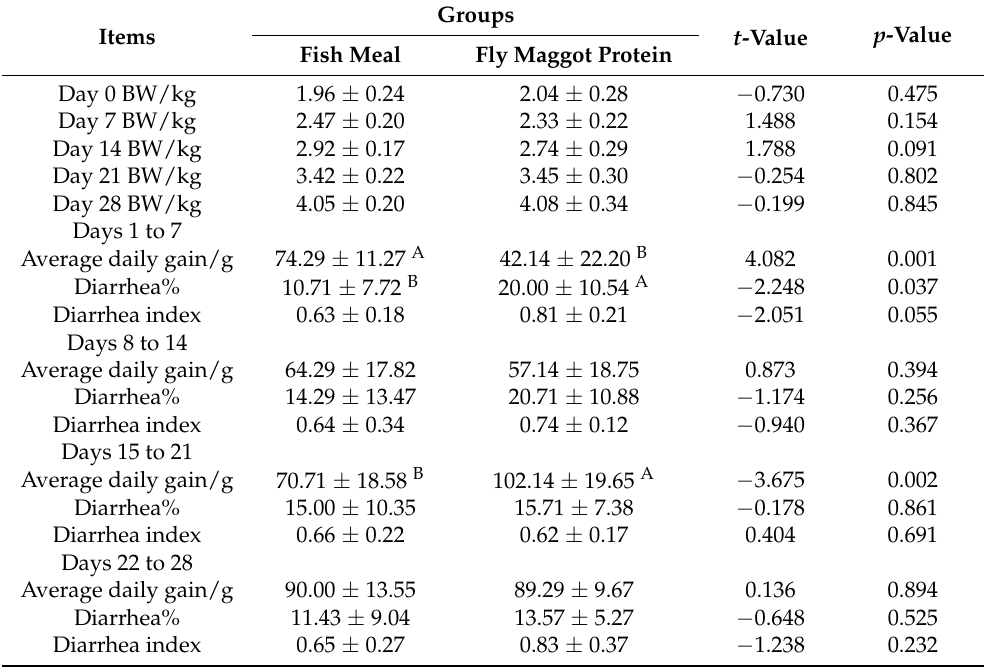
Table 3. Effects of different protein sources replacing fish meal on the growth performance of weaned blue foxes.